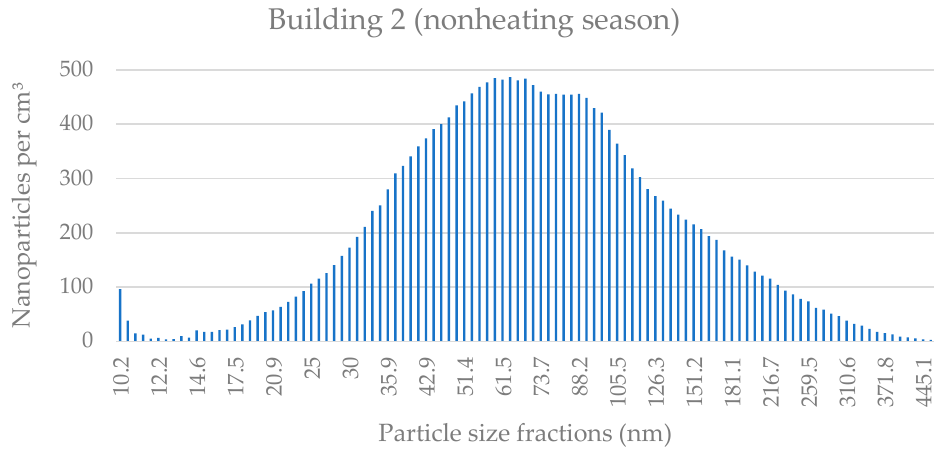
Figure A5. The average nanoparticle concentration in each size fraction in Building 3 during a one- week measurement period during the heating season. Figure A6. The average nanoparticle concentration in each size fraction in Building 3 during a one- week measurement period during the nonheating season.